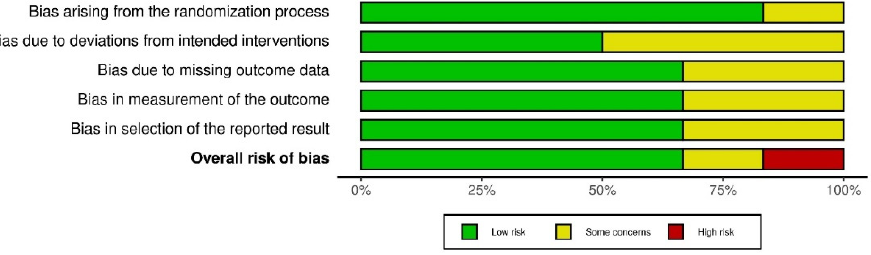
Figure 3. Summary assessment of bias of the included